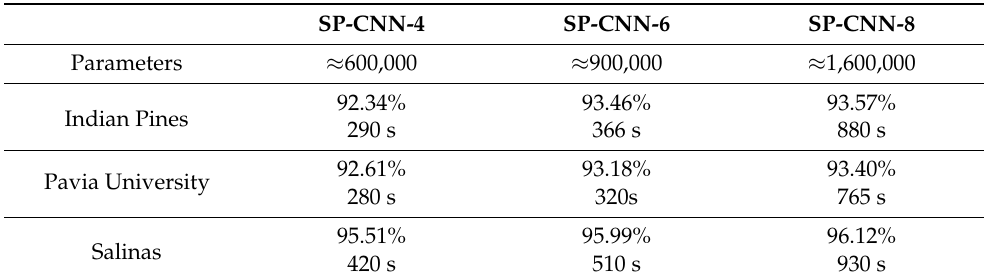
Table 6. Overall accuracy and computational time (s) of SP-CNN for different network layers on three